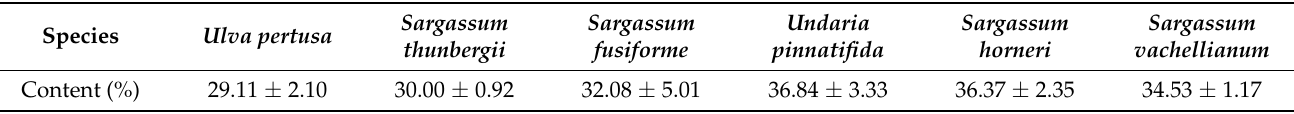
Table 3. The organic carbon content of seaweed species in the Ma’an Archipelago.